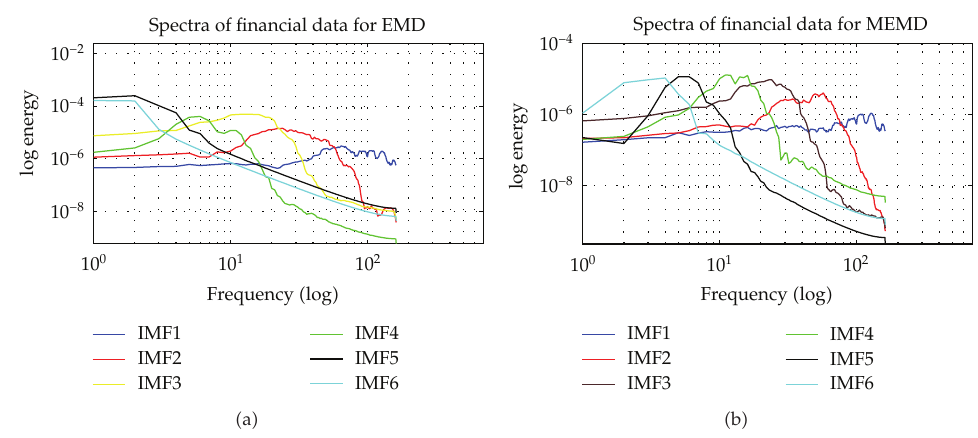
Figure 6: Spectra (cid:2) smoothed (cid:3) of IMFs (cid:2) IMF1–IMF6 (cid:3) of single financial channel obtained by EMD (cid:2) a (cid:3) and by MEMD (cid:2) b (cid:3) . The MEMD is applied on 6-channels (cid:2) 5-channels of financial data and 1 channel of WGN (cid:3)